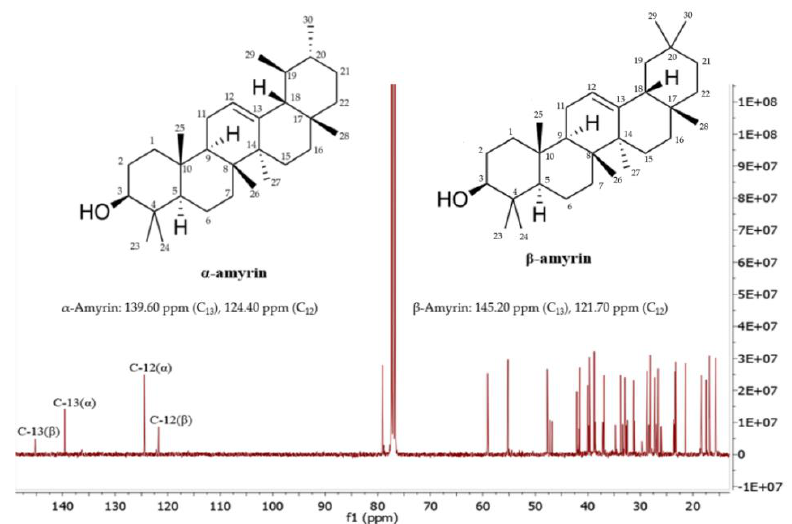
Figure 2. Identification of α -amyrin and β -amyrin by ESI-MS.